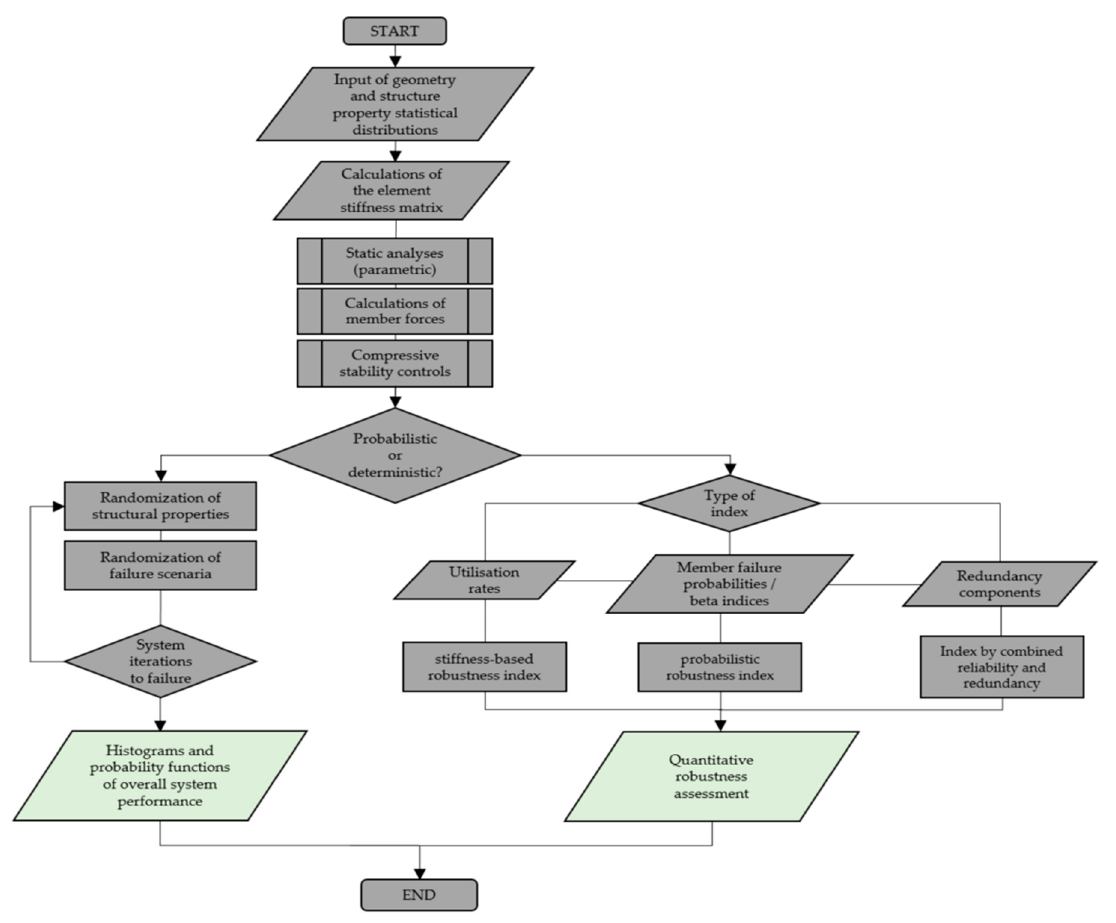
Figure 3. Flowchart of the structural and probabilistic analysis.